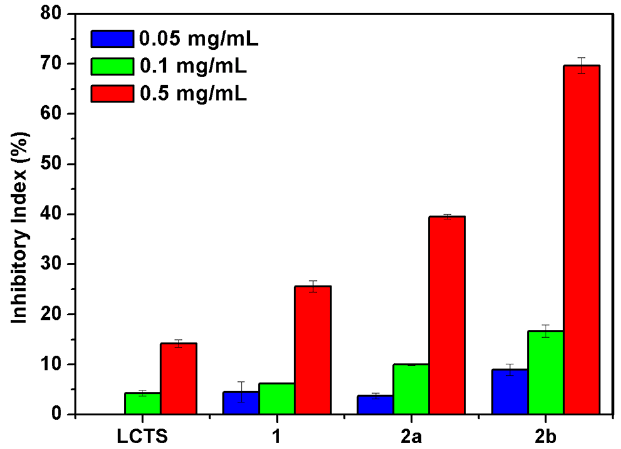
Figure 7. The antifungal activity of chitosan and chitosan derivatives against W. fusarium .